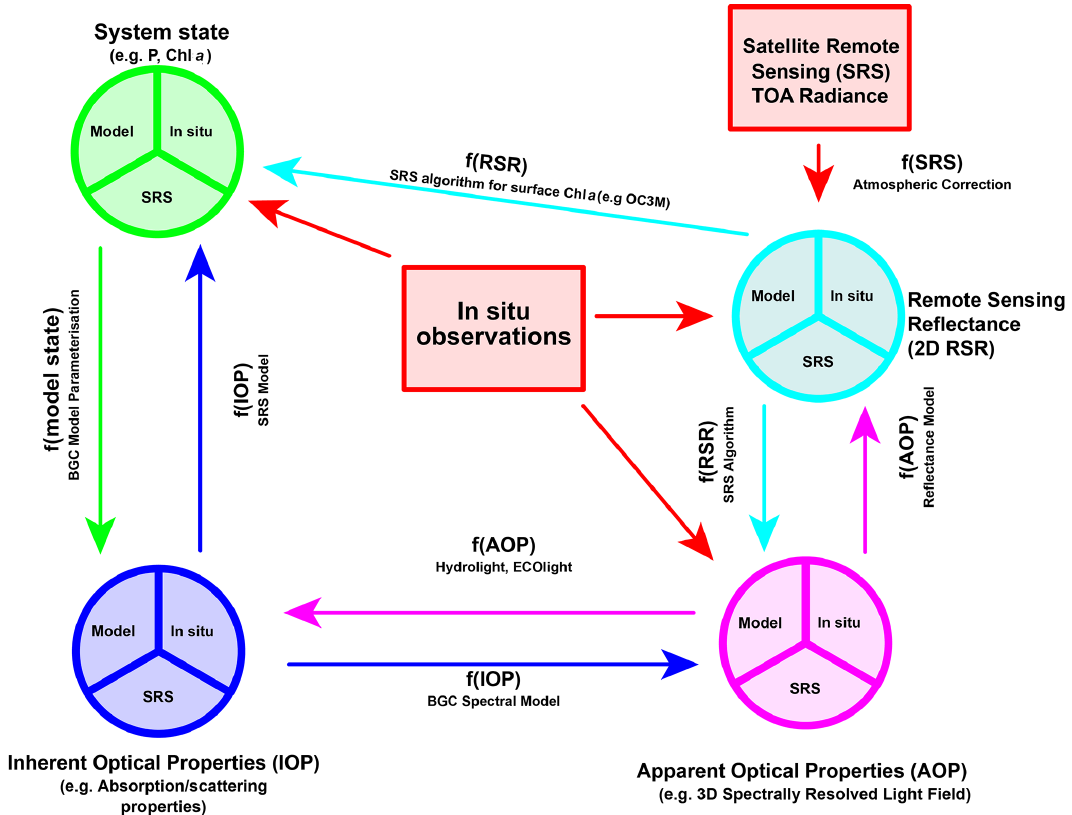
Figure 1. A diagram denoting the steps used to relate and transform various optical properties with the system state and observations. The green circle represents the in-water system state as predicted by a marine BGC model. The blue circle represents the inherent optical properties (IOPs) of the system state. The magenta circle represents the depth resolved apparent optical properties (AOPs). The cyan circle represents the 2-D remote-sensing reflectance (RSR). The two red boxes represent either in situ or satellite remote-sensing observations. Each circle is partitioned into three segments where each segment represents the possibility to compare like-for-like